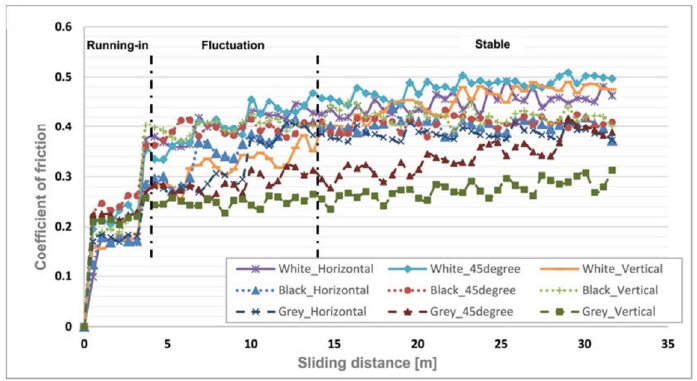
Figure 6. PLA/steel friction behavior curves [10].